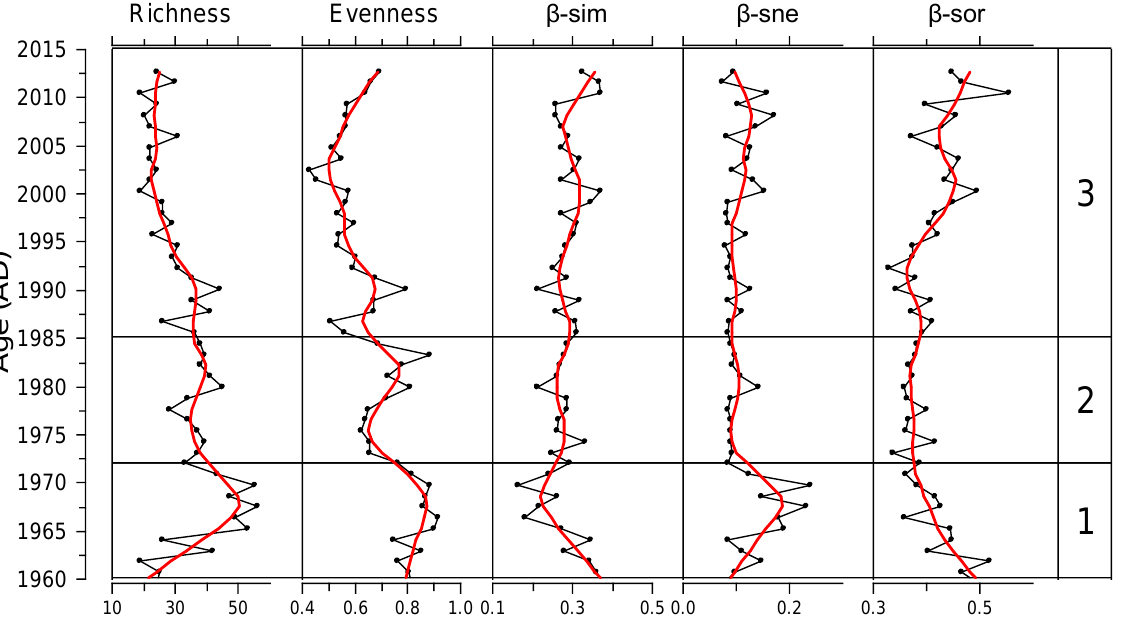
Figure 5. Profile of species richness (richness), species evenness (evenness), and β -diversity (β -sim, β -sen, and β -sor) in the three diatom zones.